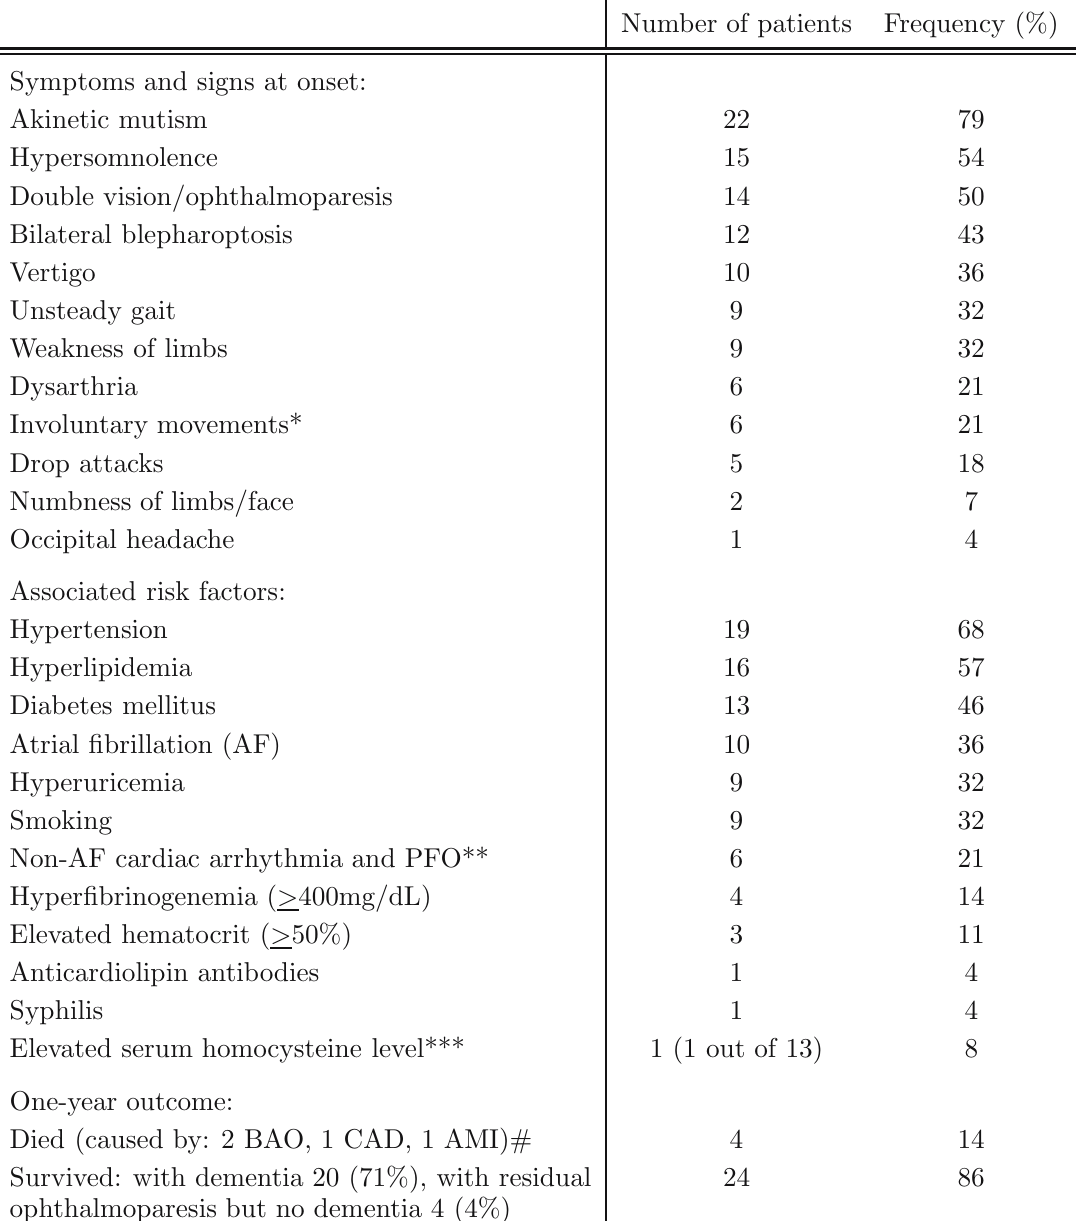
Table 1 Frequency of symptoms and signs at onset, associated risk factors, and one-year outcome of 28 patients with paramedian mesencephalic artery syndrome